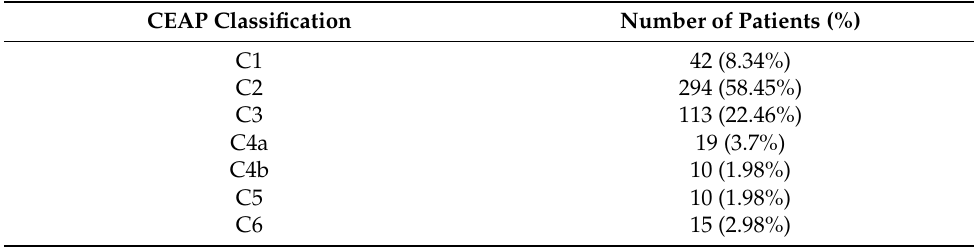
Table 2. The CEAP classification before